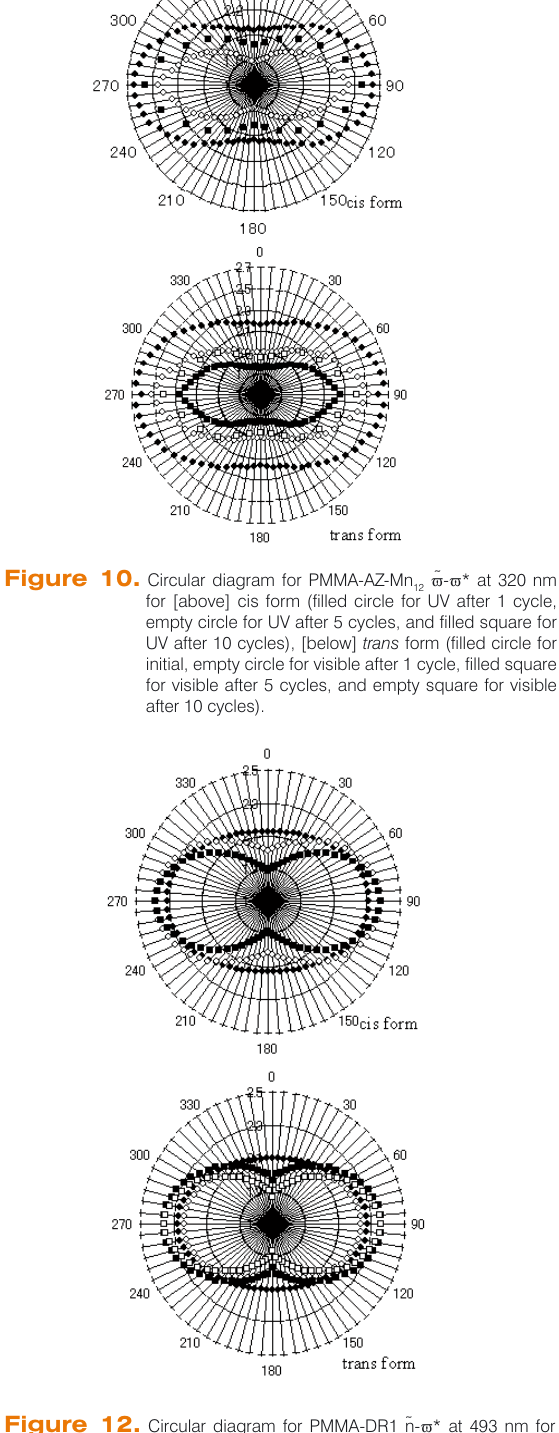
n  - ϖ * at 485 nm 12